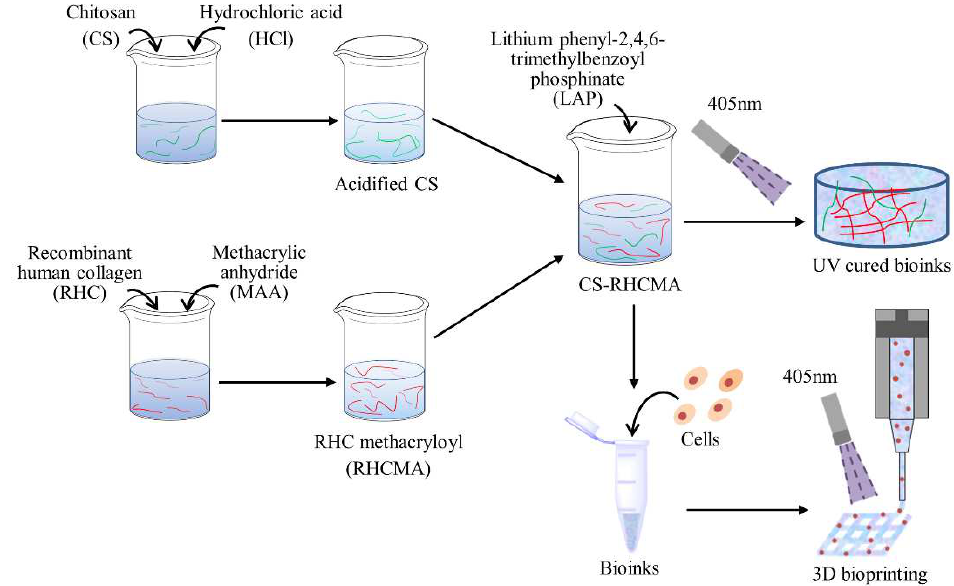
Figure 1. Schematic diagram of preparation of the CS-RHCMA bioinks.